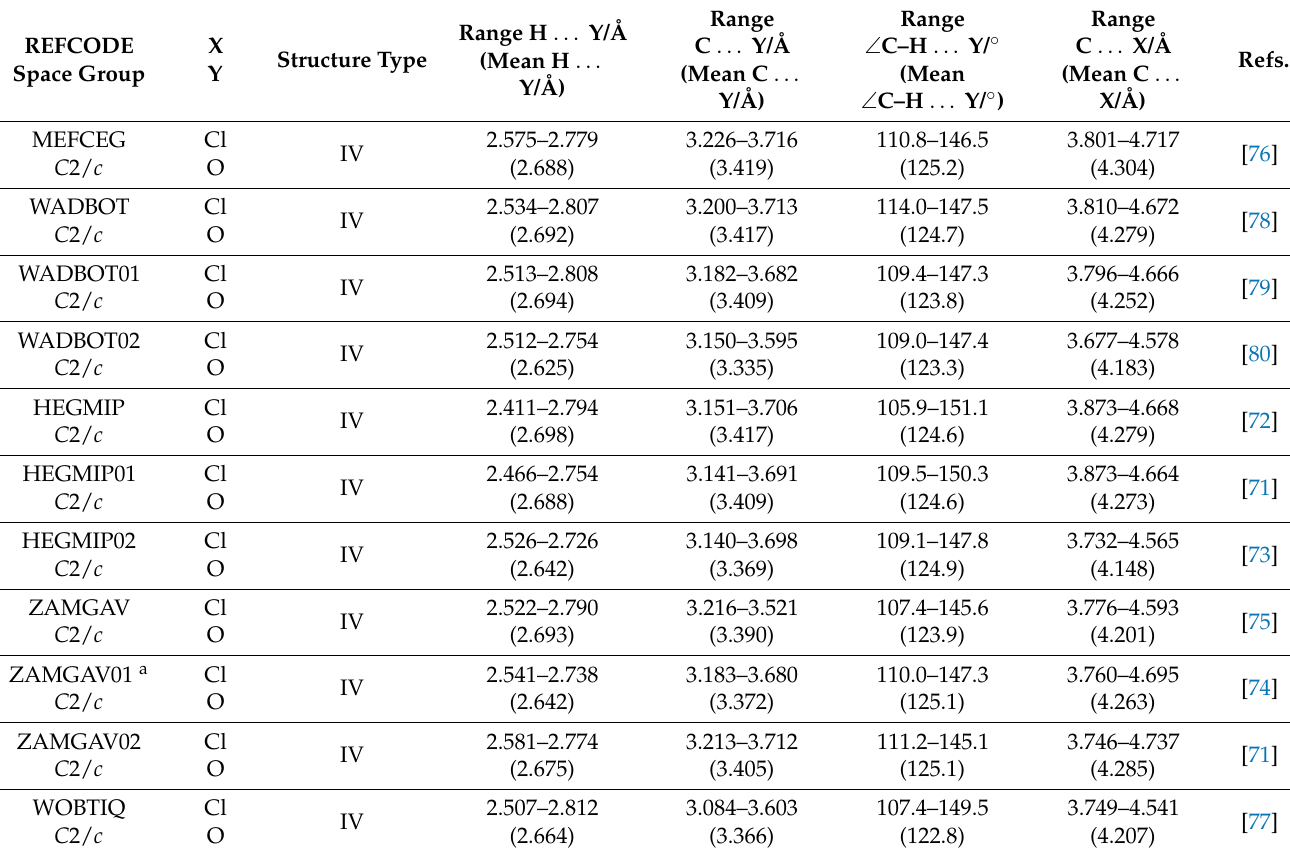
Table 5. Structure Type IV motifs with [ClO 4 ] –